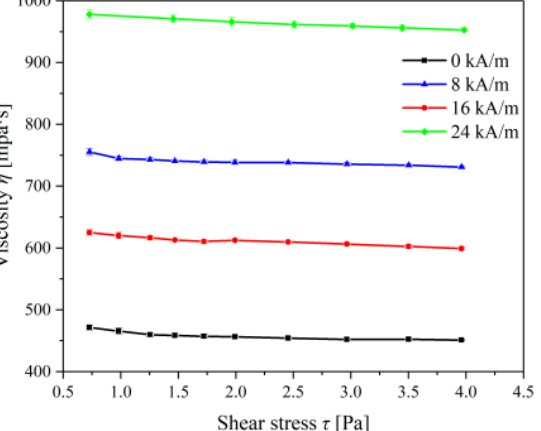
Figure 9. Viscosity changes with shear stress under different magnetic fields.